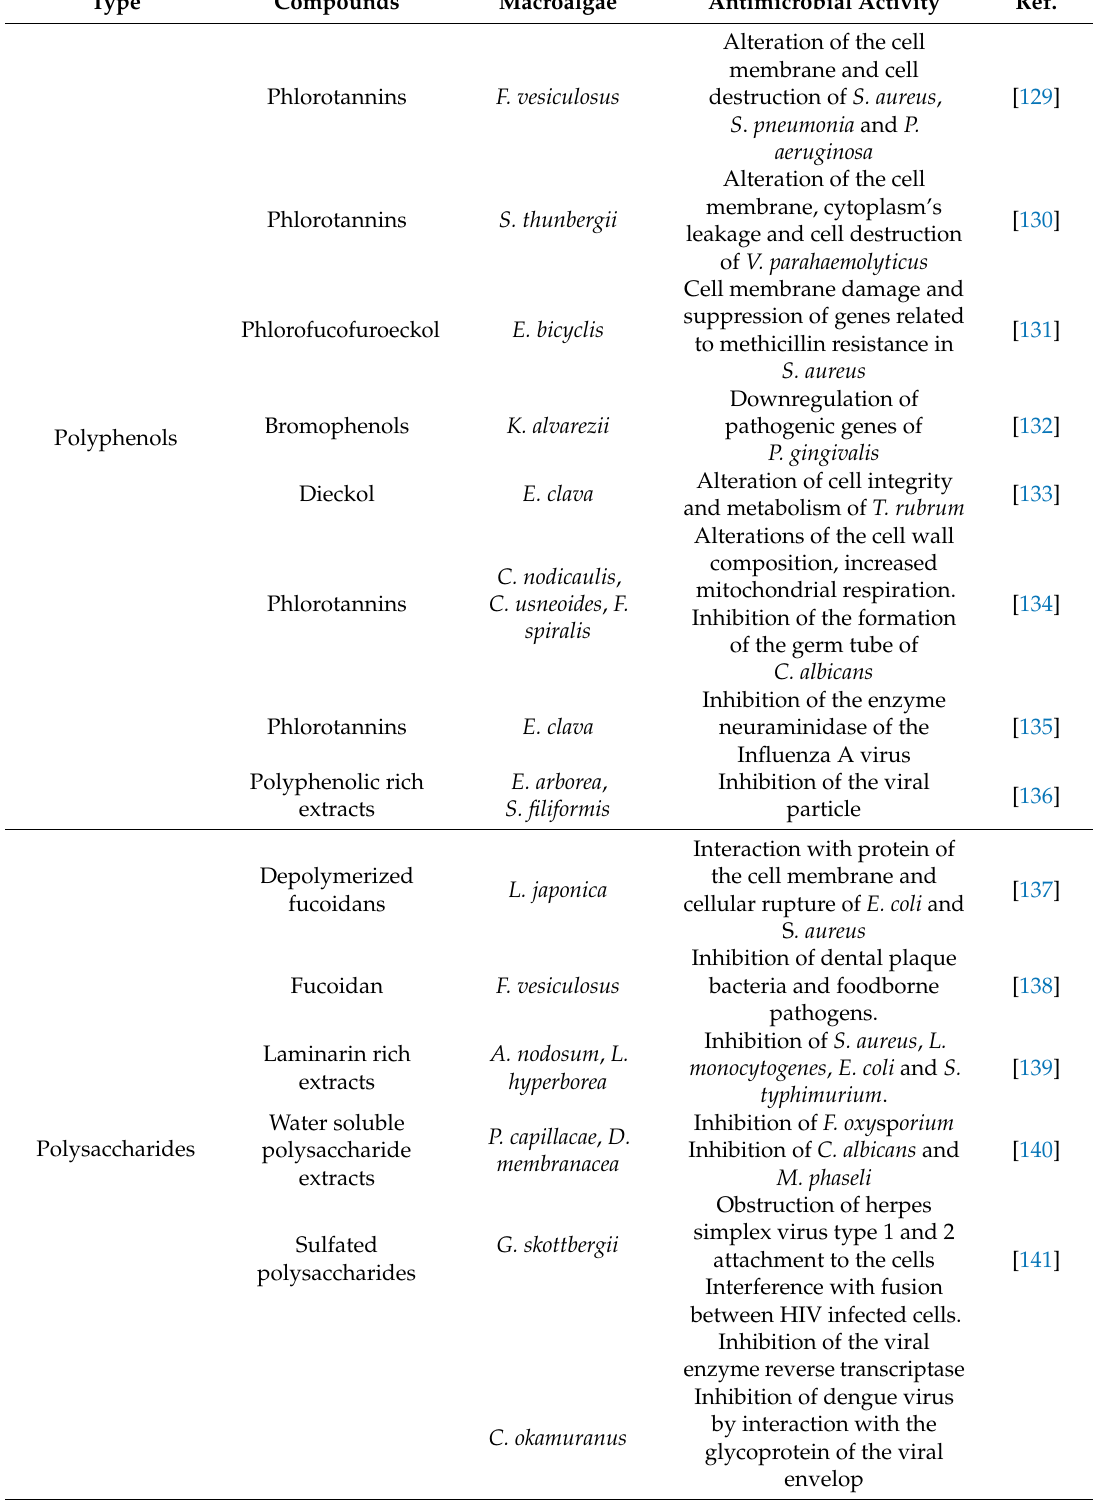
Table 2. Antimicrobial properties of compounds extracted from